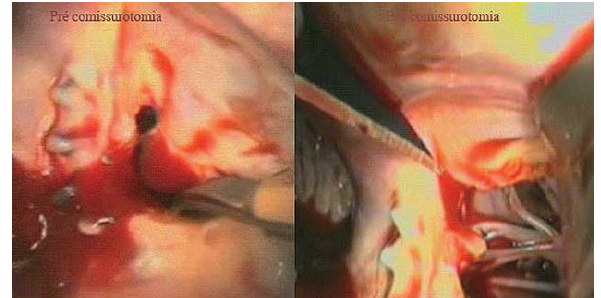
Fig. 4 - Aspecto videoscópico da valva mitral, pré e pós